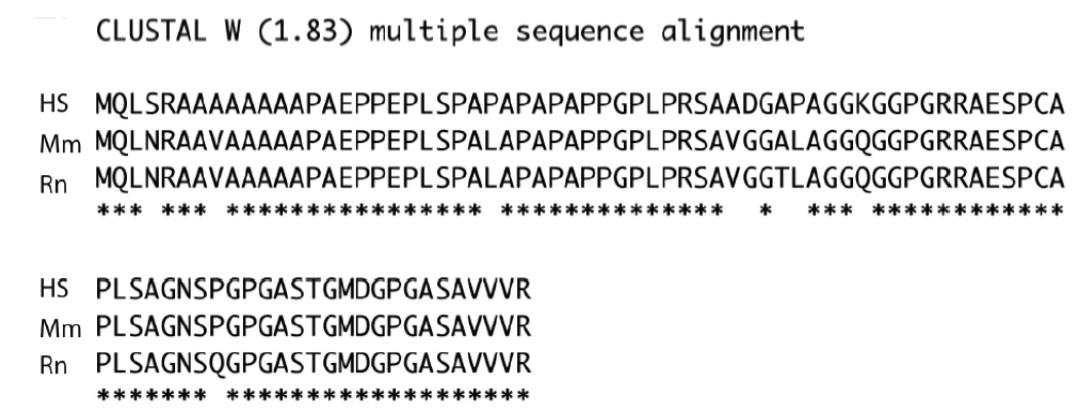
Figure 1. Identification of a new human SHANK3 isoform. ( A ) LC-MS/MS identifies a SHANK3 tryptic peptide (Peptide 2) corresponding to a novel human SHANK3 isoform previously only identified in mouse and rat. Endogenous MCC was immunoprecipitated from SW480 human colon cancer cells. The immunoprecipitate was processed for LC-MS/MS and the data searched using Mascot. Among the tryptic peptides identified, two peptides corresponded to the SHANK3 protein; ( B ) Endogenous Mcc interacts with endogenous Shank3 in mouse brain tissue. Endogenous Shank3 and Mcc were immunoprecipitated (IP) from mouse brain tissue. Lysates and immunoprecipitates were run and blotted for Shank3 and Mcc; ( C ) Confocal microscopy for paraformaldehyde-fixed SW480 and HCT116 cells probed with anti-SHANK3 (green) and anti-MCC antibodies (red) show partial cell membrane colocalisation; ( D ) Shown is the region of the human genome sequence encompassing chr22:50,674,415 to chr22:50,674,677 that was extracted from UCSC Dec 2013. GRCh38/hg38. ORF: Open Reading Frame; uORF: upstream Open Reading Frame. Translation of chr22:50,674,415 to chr22:50,674,677 using three open reading frames. Amino acids in red are found in the mouse or rat Shank3 protein. The predicted new N -terminal amino acids sequence is derived from the first 54aa of Frame 1 (F1) followed by the second tryptic peptide. The beginning of the known translated region is underlined in blue; ( E ) Multiple alignment of mouse Shank3, rat Shank3 and